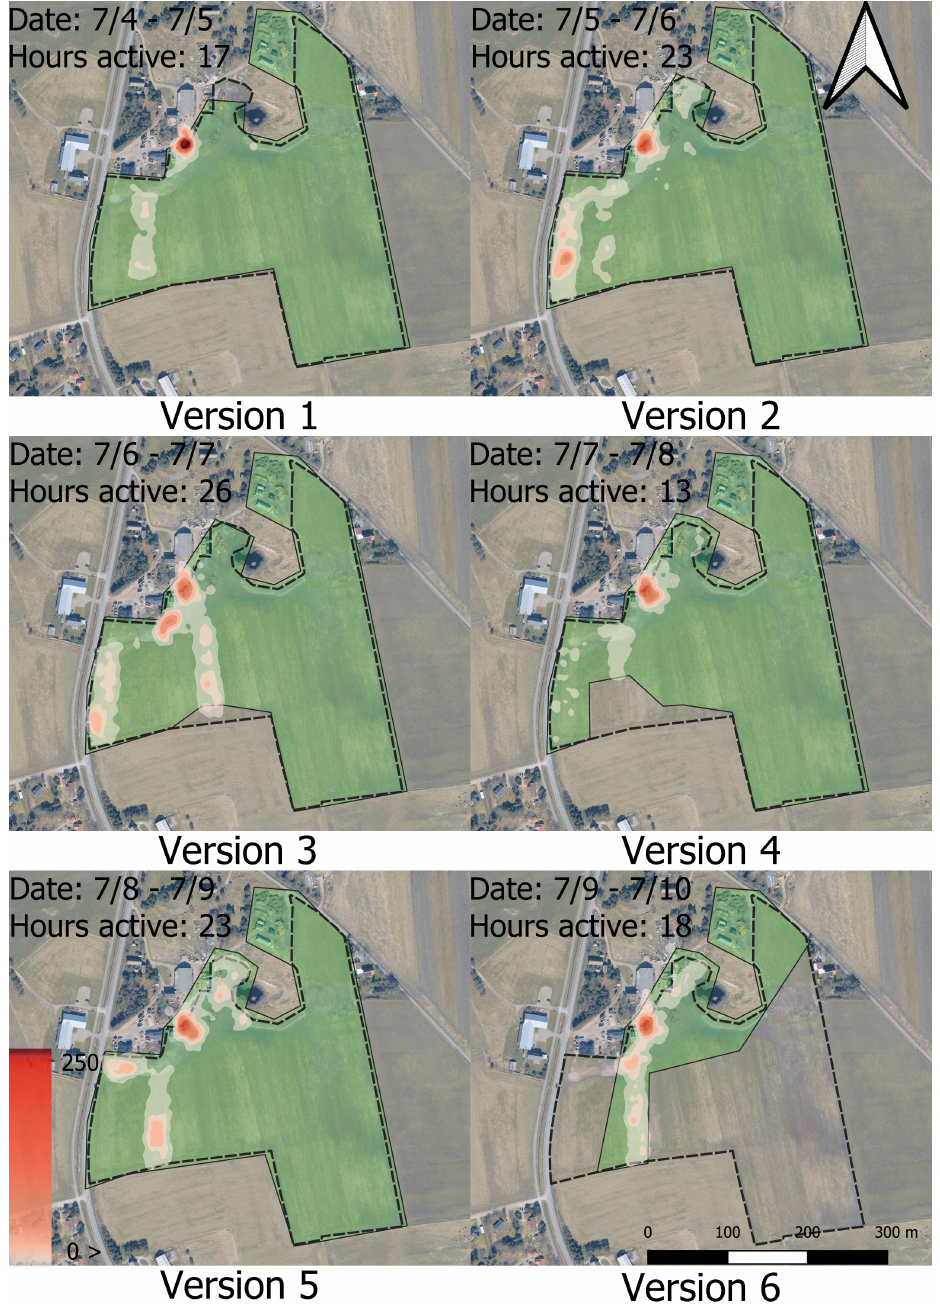
Figure A10. Heatmap series 1 visualising all Poll messages sent during the period from 4 July to 10 July. The green area shows the virtual enclosure area to which the bull calves were limited. The white to red colour indicates the number of Poll messages within a 10 m radius. The brightest colour represents the areas with the lowest density of Poll messages, while the darkest colour represents the areas with 250 or more Poll messages within the radius. The coordinates of the upper left corner of the map frame are 55°25 (cid:48) 23.131 (cid:48)(cid:48) E 8°23 (cid:48) 53.531 (cid:48)(cid:48) N. Contains data from the Agency for Data Supply and Infrastructure, Forårsbilleder Ortofoto-GeoDanmark, December